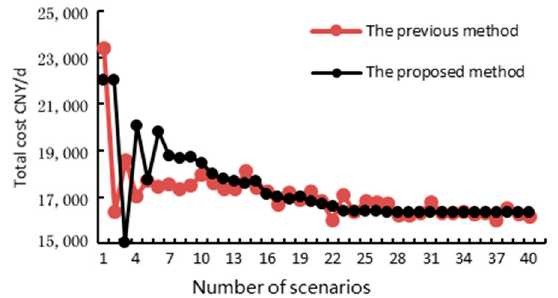
Figure 6. Mean value of daily total cost in different scenarios.